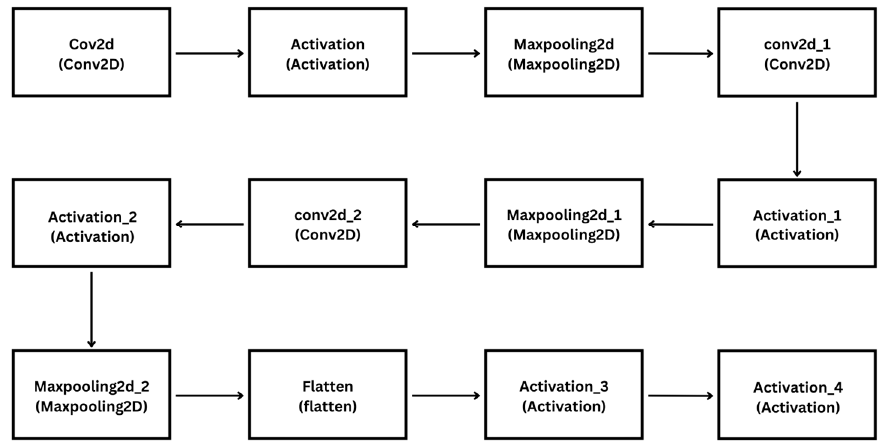
Figure 2. The suggested CNN model’s architecture.